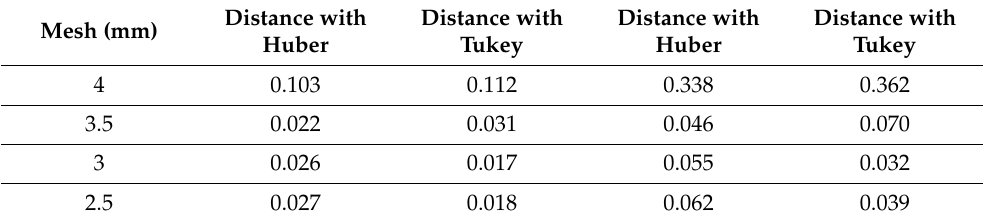
Table 12. Statistical analysis with different